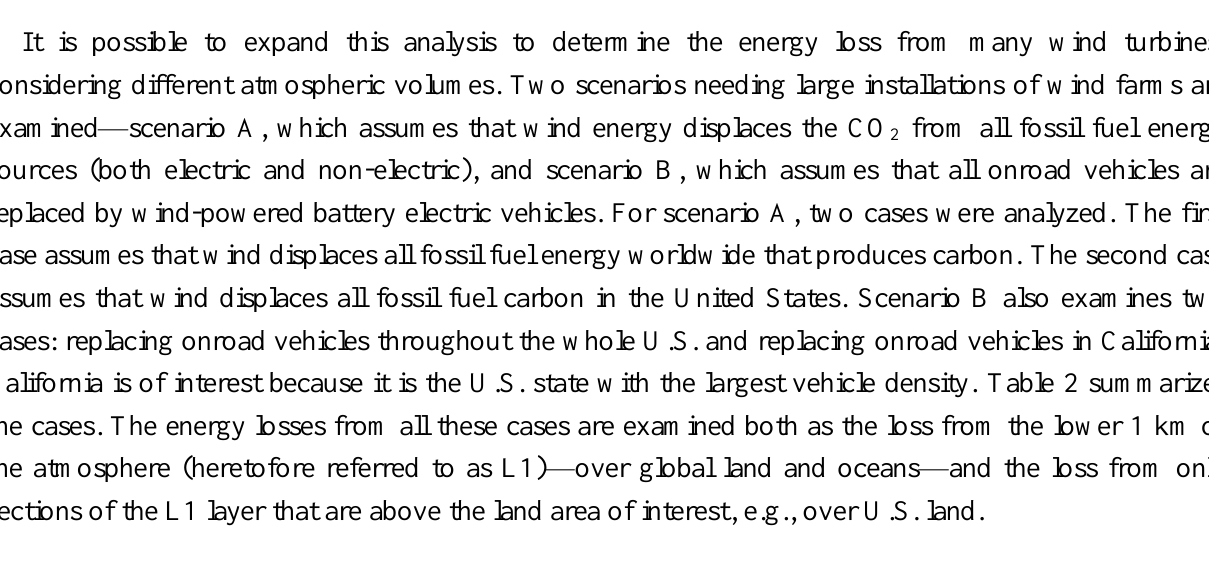
Table 2. Different cases and scenarios used in the analysis of the energy loss from large wind